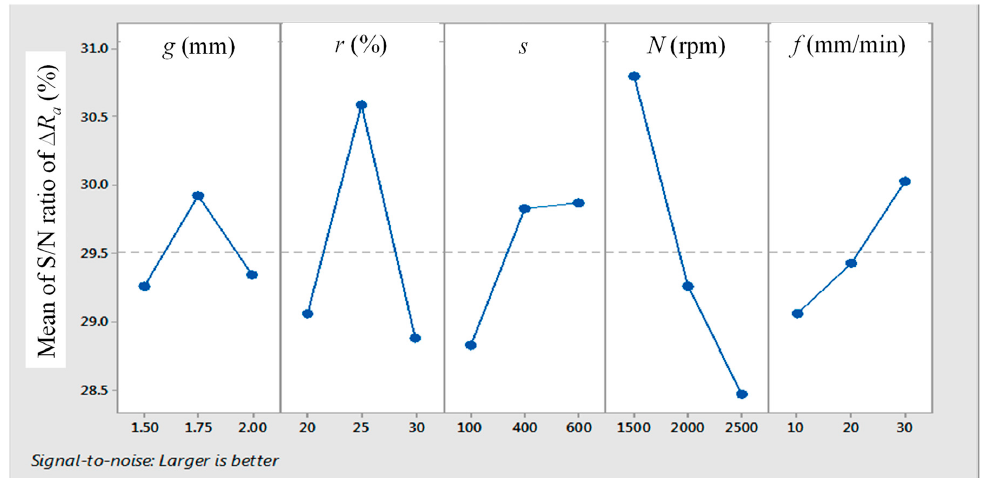
Figure 5. Signal-to-noise (S/N) ratio plots of ∆ R a (%) for SiC abrasive ( g = working gap, r = percentage of abrasive, s = abrasive mesh number, N = rotation speed, and f = feed rate).